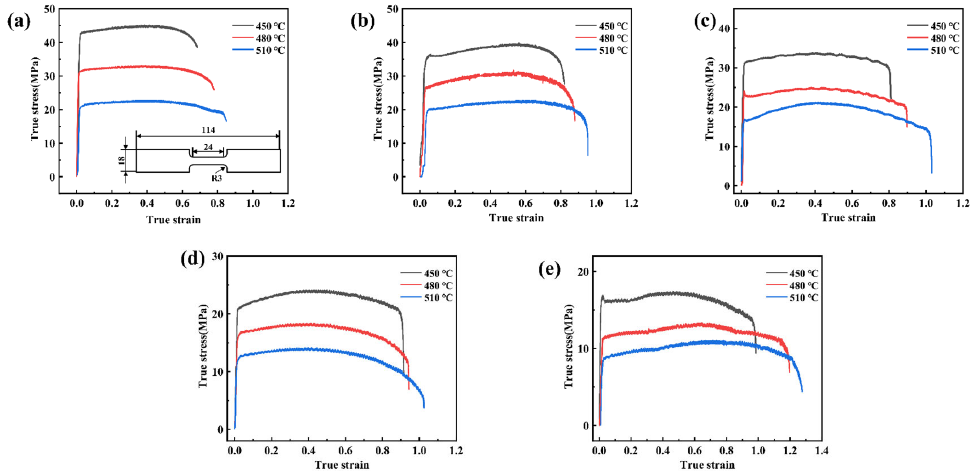
Figure 1. Flow stress curves at different strain rates and the shape and dimensions of the tensile . specimen ( a ) ε = 1 × 10 − 2 s − 1 , ( b ) specimen ( a ) . ε = 5 × 10 − 4 s − 1 ( e )